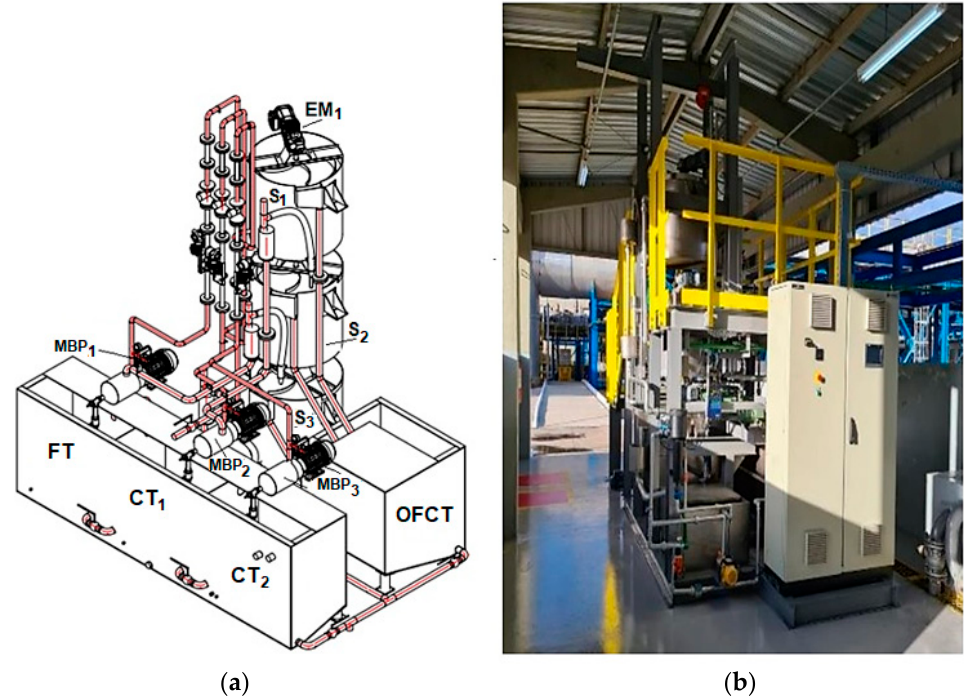
Figure 2. ( a ) Isometric drawing of the semi-industrial induced pre-saturation tower (IPST); ( b ) IPST installed in an industrial unit (authors’ photography).